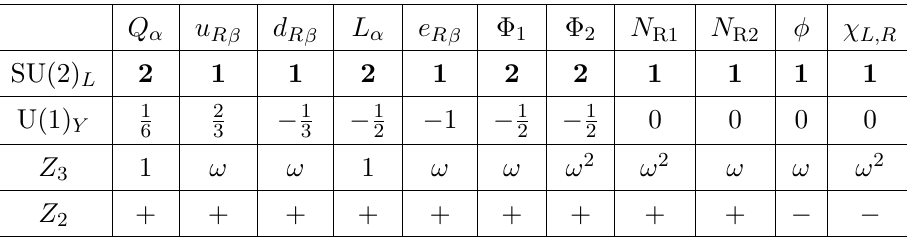
Table 1 . Irreducible representations of the fields of the model under the electroweak SU(2) L × U(1) Y gauge symmetry, the discrete Z 3 symmetry (where we write ω = e i 2 π/ 3 ) and the unbroken Z 2 dark symmetry. The fields Q α , L α are left-handed SM doublets while u Rβ , d Rβ , e Rβ are right-handed SM singlets where α, β = 1 , 2 , 3 label the three families of quarks and leptons. The fields N R1 , 2 are the two right-handed neutrinos, while φ and χ L,R are a dark complex scalar and dark Dirac fermion,